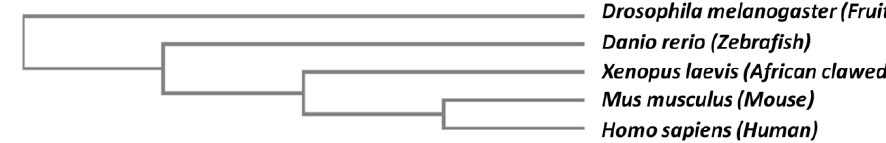
Figure 2. A human KLF family phylogenetic tree generated using the Clustal Omega tool (https://www.ebi.ac.uk/Tools/msa/clustalo/). There are 17 members of the human KLF family, which can be further classified into three subgroups. KLF7 is the closest to KLF6 in the phylogeny.